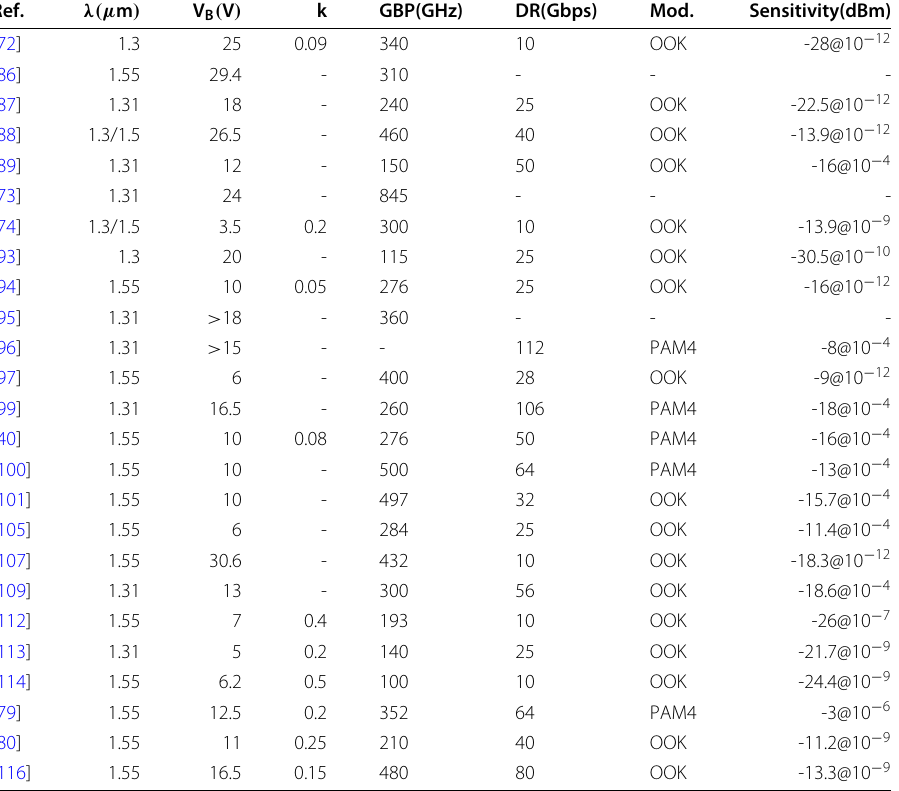
Table 1 Performance metrics of state-of-the-art Si–Ge avalanche photodiode receivers